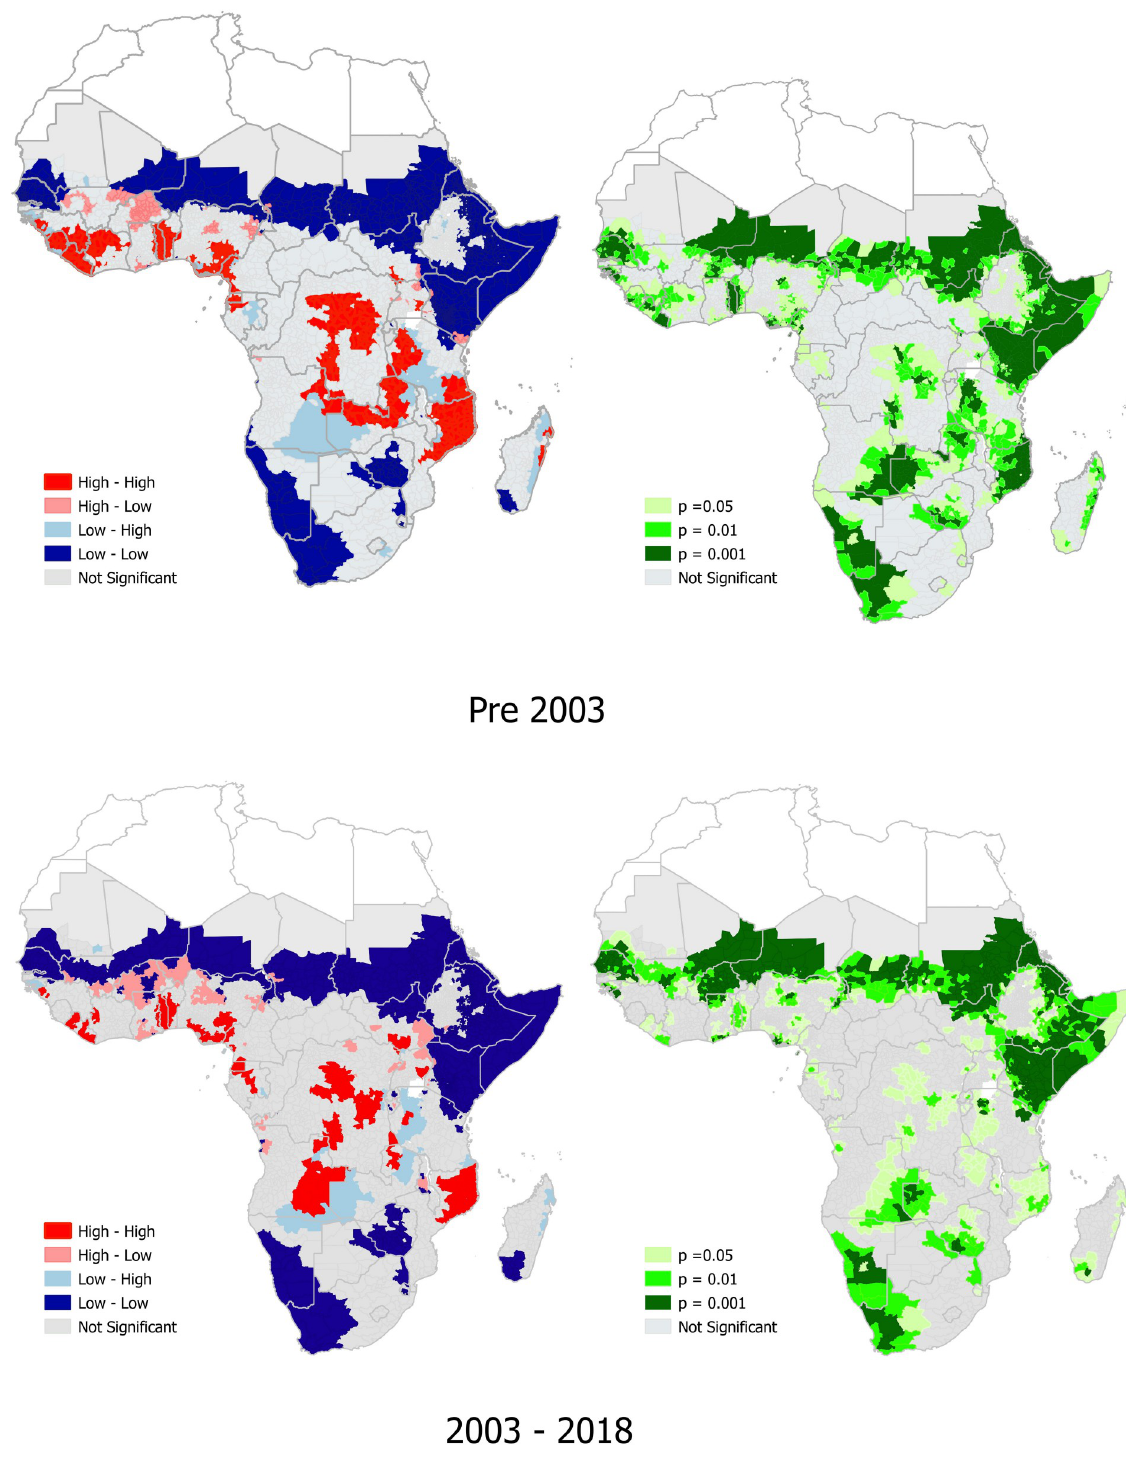
Fig 2. The prevalence of P . falciparum and hookworm co-endemicity, and significant hotspots of P . falciparum and hookworm co- endemicity in sub-Saharan Africa. ’The density description next to the colour coded box refers to the prevalence of P . falciparum , whilst the column further to the right refers to density of hookworm. Link to the base layer of the map: https://gadm.org/index.html.